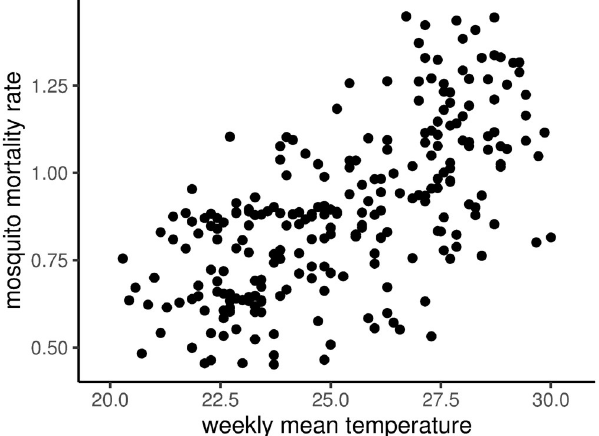
Fig 2. Mosquito mortality and temperature. Posterior median mosquito mortality rate as a function of weekly mean temperature (degrees Celsius).